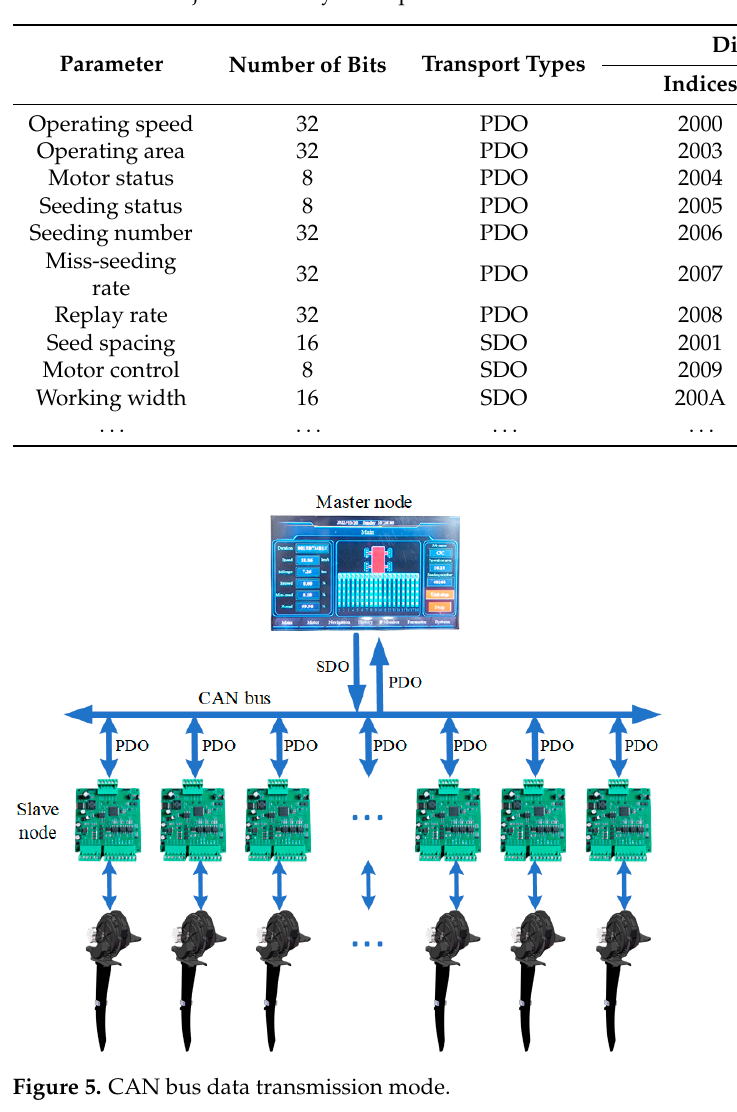
Table 1. Partial object dictionary description.